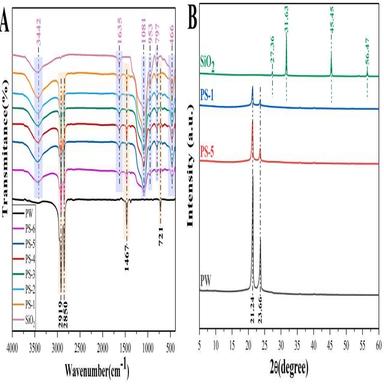
FTIR spectra (A), and XRD patterns of the samples (B).